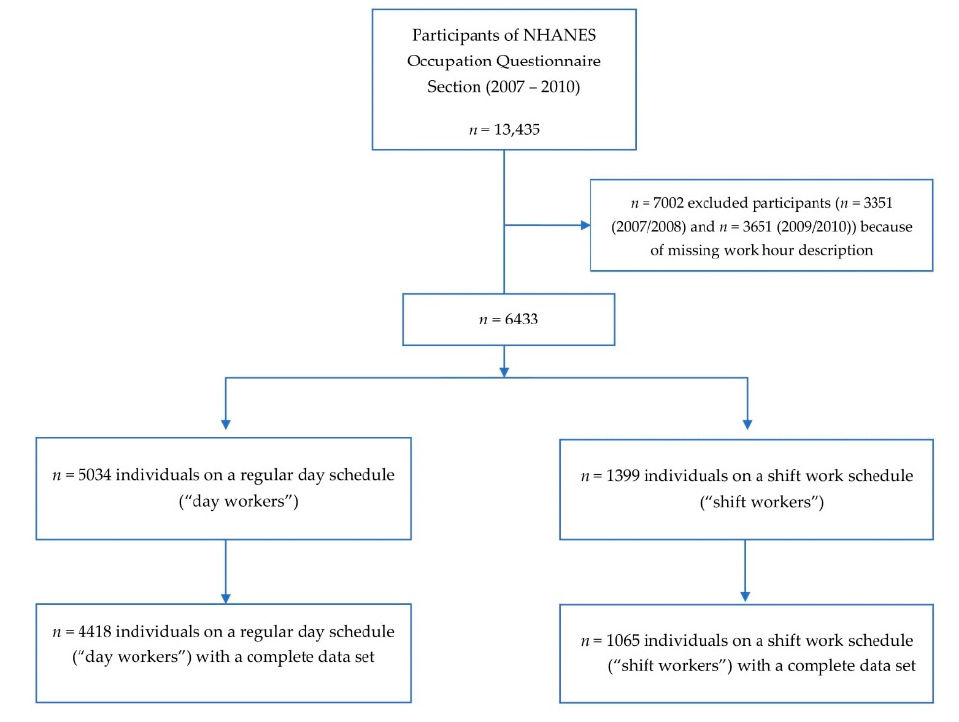
Figure 1. Participant inclusion flow chart: NHANES 2007–2010. Table 1. Study sample characteristics: a comparison by shiftwork